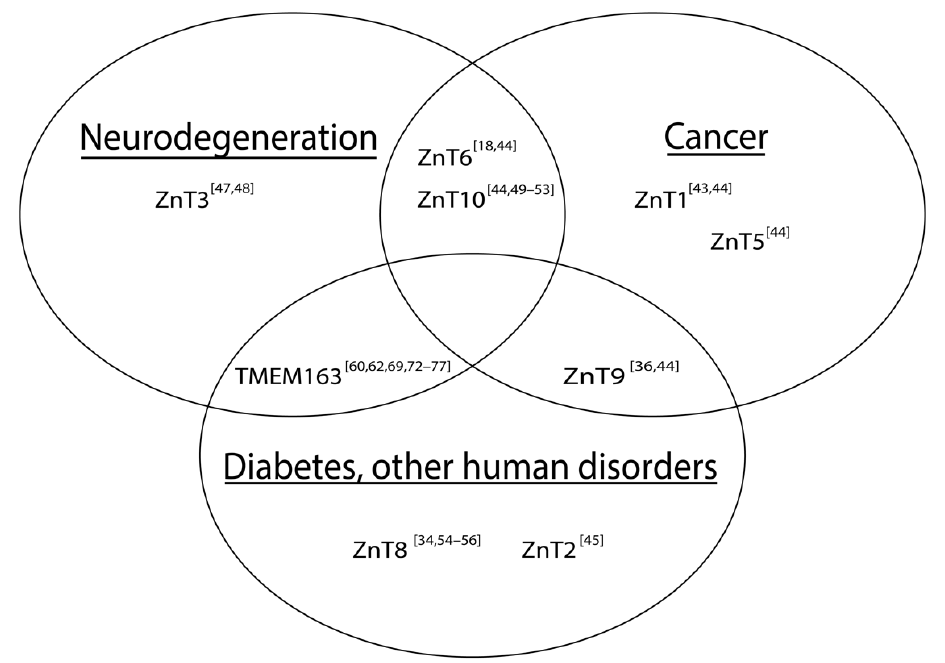
Figure 1. Schematic illustration of associations between altered SLC30 (ZnT) expression and notable human diseases. The Venn diagram includes TMEM163, which has been implicated in certain human diseases. References are represented as numbers in brackets.